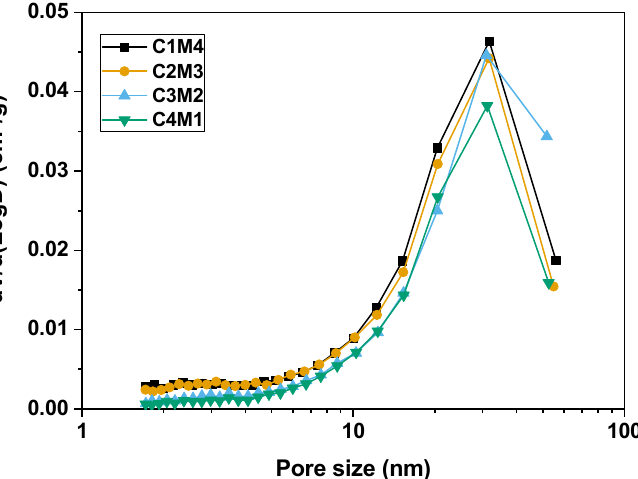
Figure 10. Pore size distribution curves of the Na 2 CO 3 –activated slag binders modified with Ca(OH) 2 and Mg(OH) 2 .